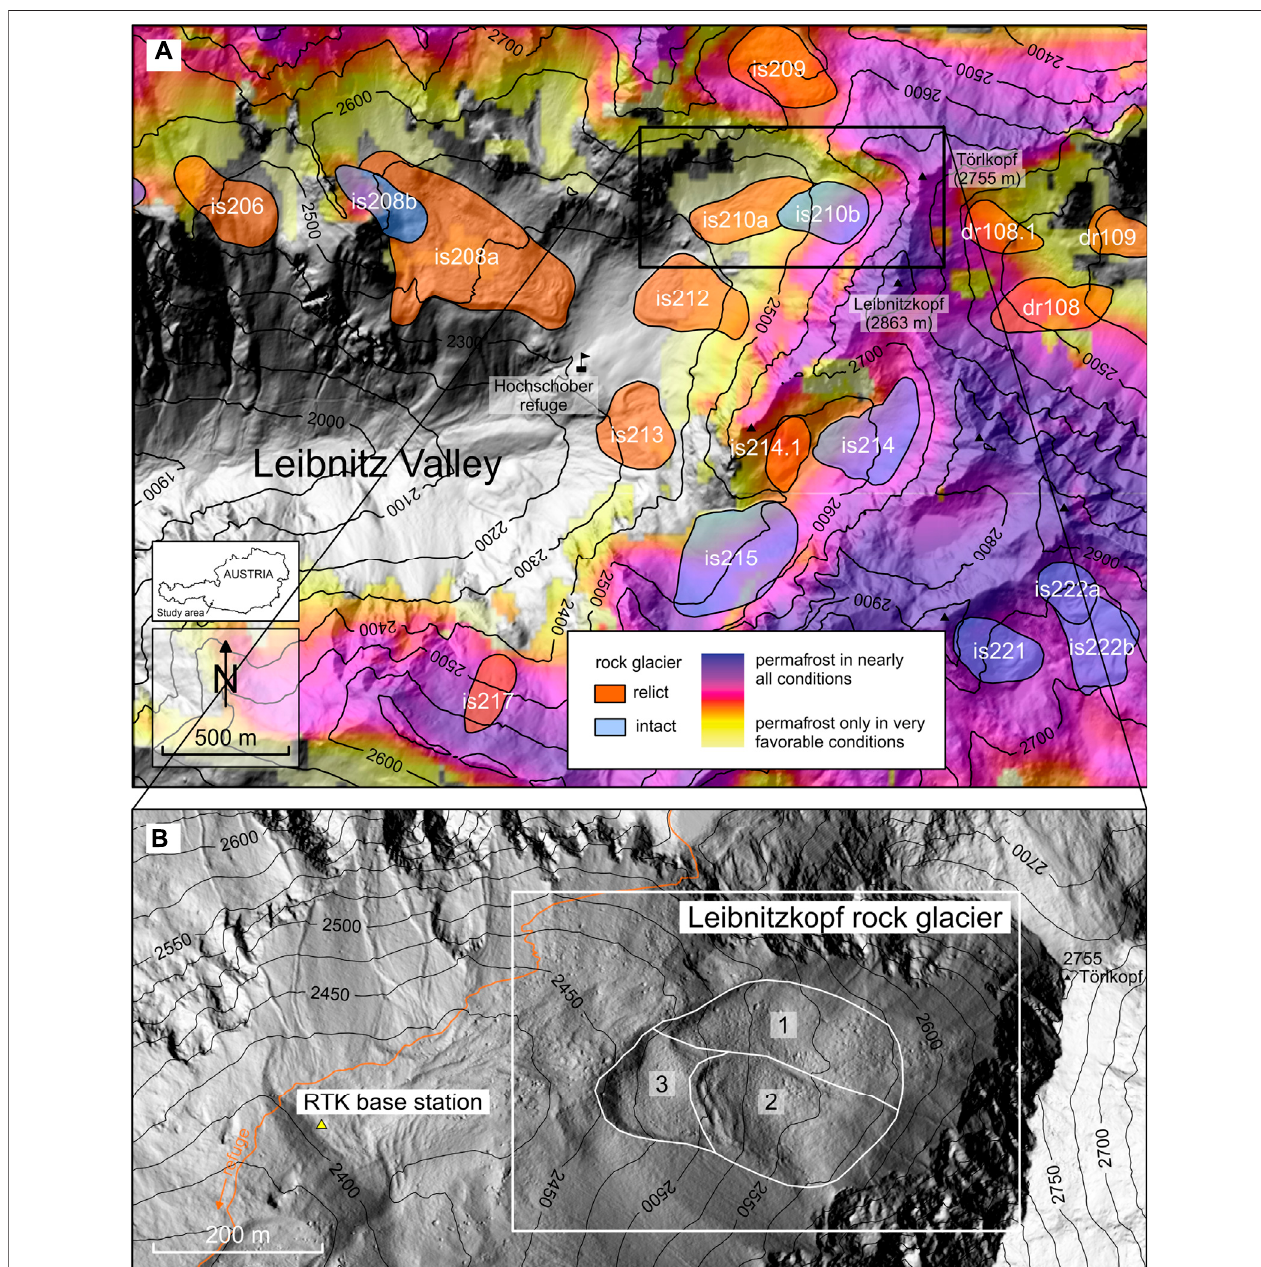
FIGURE1|(A) Locationmap: Shaded relief basedon ALSdata (September 08,2009) showing thestudy area(Leibnitzkopf rock glacier, WGS 1984:46 ° 55 ′ 51.5 ″ N, 12 ° 42 ′ 42.9 ″ E) and its surroundings. ALS data © Of fi ce of the Tyrolean Regional Government. (B) Close-up of the study area. The white rectangle shows the map sections depicted in Figures 3 , 4 , 5A . The different rock glacier units 1 – 3 discussed in the text are outlined.